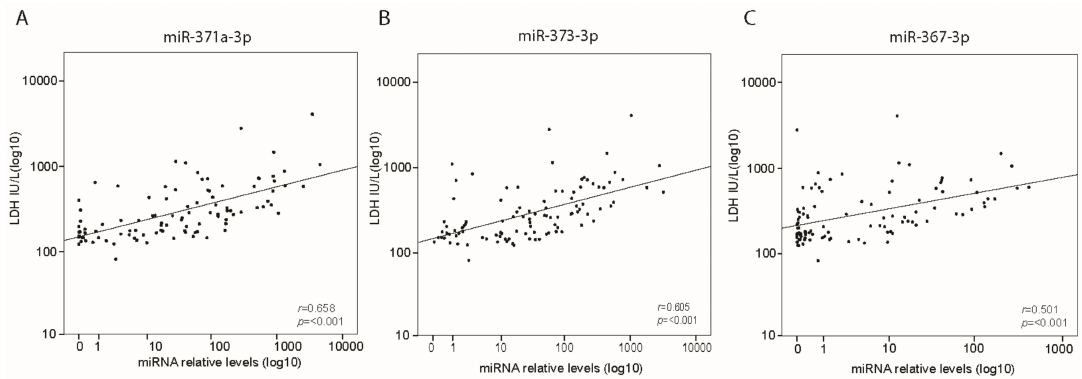
Figure 2. Spearman correlation of relative levels of miR-371a-3p ( A ), miR-373-3p ( B ) and miR-367-3p ( C ) and LHD before start of chemotherapy in cohort 1 and 2 combined ( n =